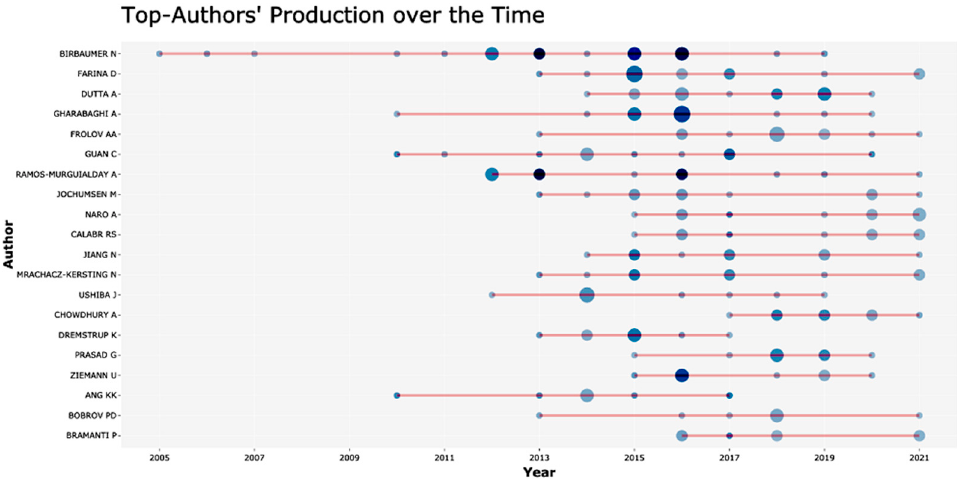
Figure 2. The figure shows the scientific production of the most influential authors. Table 3. Top-20 scientific production by country.